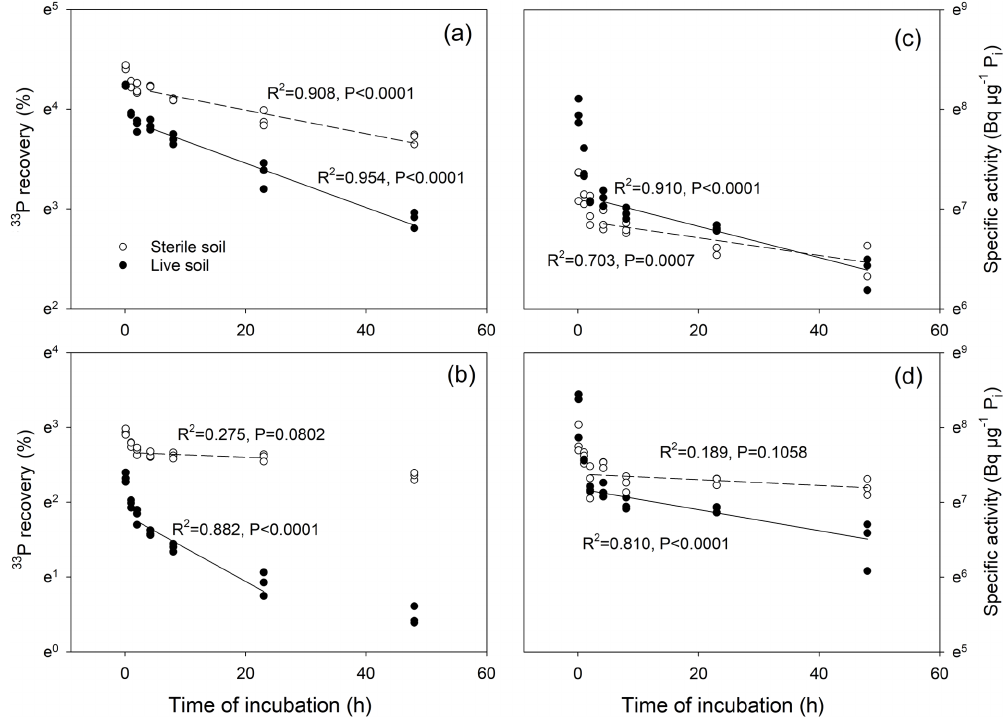
Figure 5. Test for linearity of change in 33 P recoveries (a, b) and in specific activities of P i (c, d) over time, for a temperate grassland soil (a, c) and a tropical forest soil (b, d) . Data presented are for 33 P measured directly in bicarbonate extracts of live soils (closed circles) and sterile soils (open circles), and are shown in a logarithmic manner (LN) on the y axes. Regression lines follow exponential decay which in this linear–LN plot appears as a straight line; dashed lines represent sterile soils, and solid lines represent live soils. Regressions were calculated for the time intervals from 2 to 24h (tropical soil) and from 4 to 48h (temperate